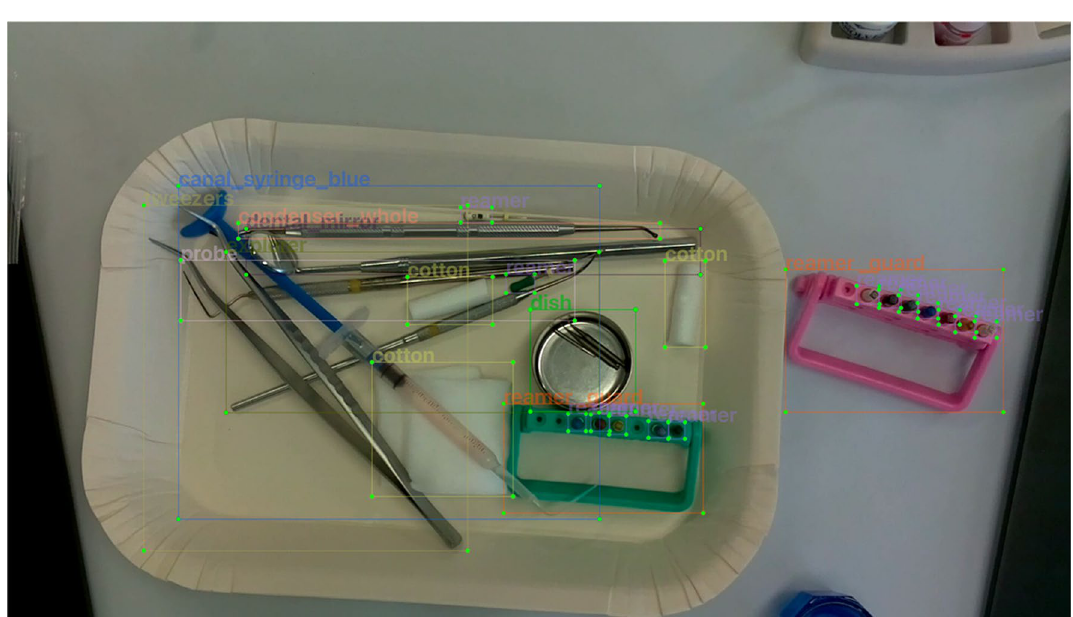
Figure 3. Example of labeling of entire part of instrument (AB). The entire parts of instruments to be detected were surrounded by BBs and labeled to record the type of